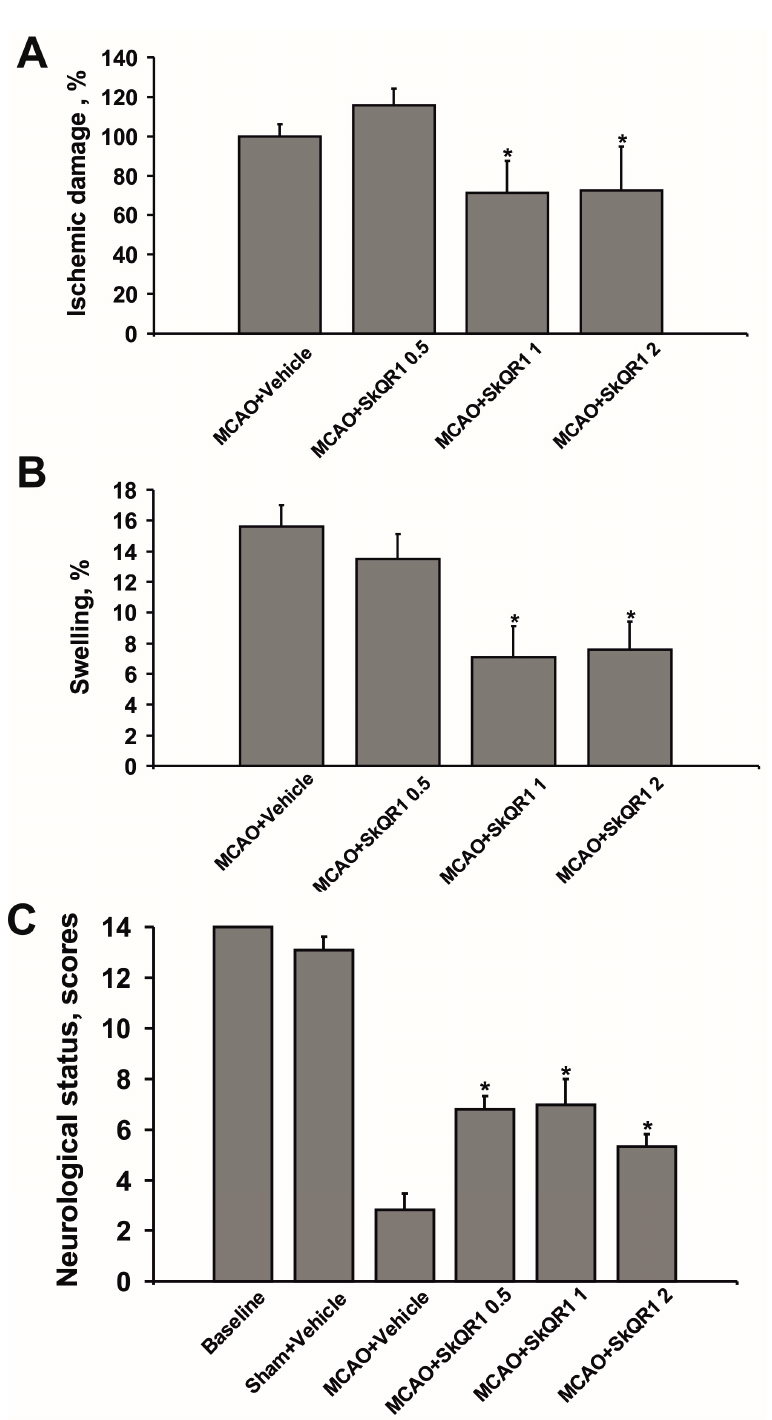
Figure 3. The treatment with SkQR1 protects the ischemia-injured brain. Rats were given i/p SkQR1 at doses 0.5, 1, or 2 μ mol/kg after the beginning of reperfusion. ( A ) Infarct volume and ( B ) brain swelling measured in the MR T2-weighted images; ( C ) Neurological status estimated by limb-placing test. * denotes significant difference from the MCAO + Vehicle or MCAO groups ( p < 0.05) (One-way ANOVA, followed by Tukey’s post hoc analysis for ( A , B ); Kruskal-Wallis test with the Mann-Whitney u -test for ( C